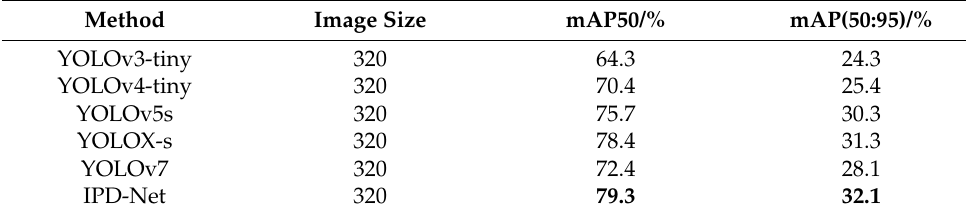
Table 3. Experimental comparison of IPD-Net with YOLO series